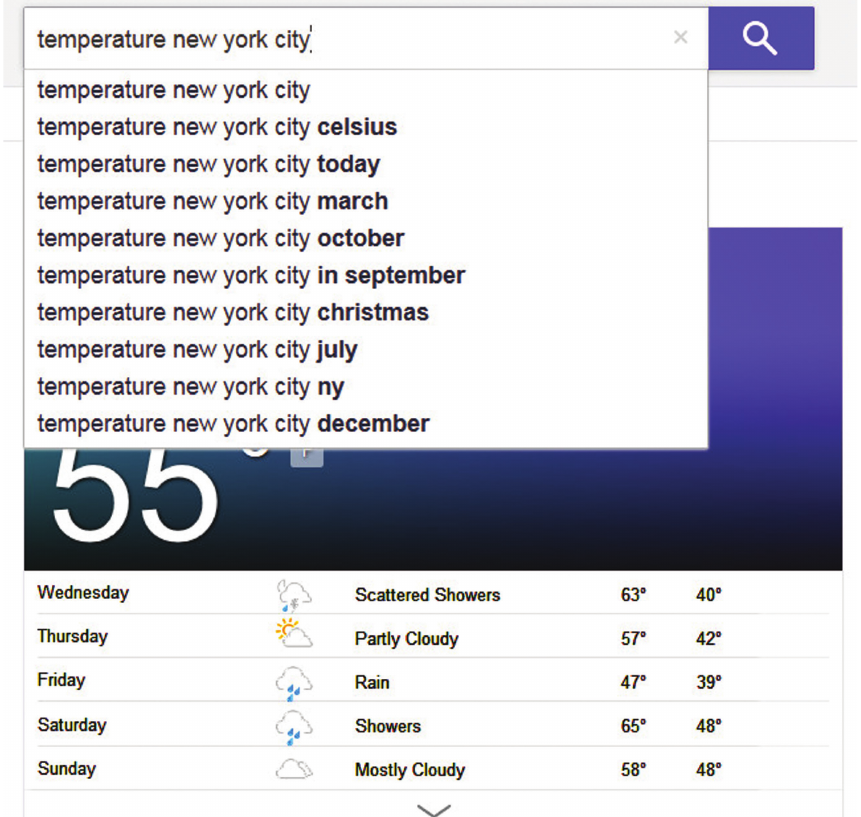
Fig. 1: Search suggestions for ‘temperature New York